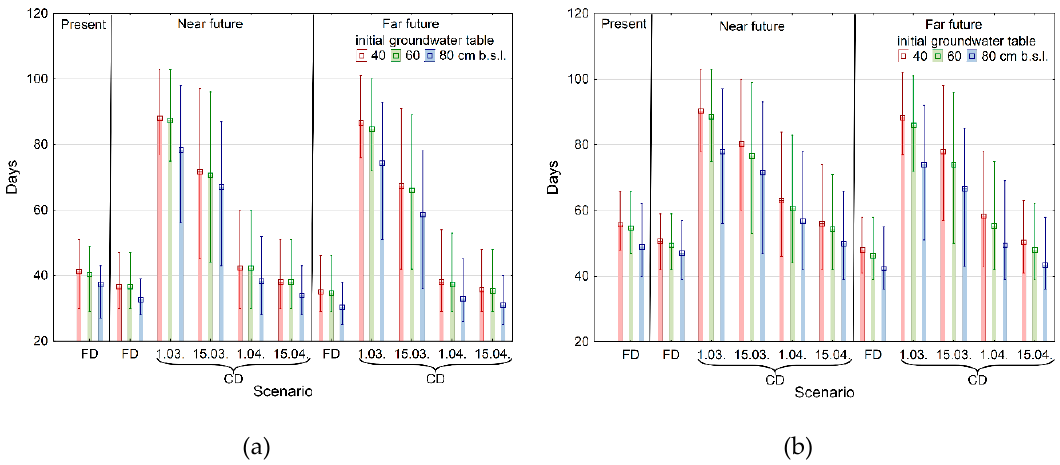
Figure 4. Impact of climate change on the time of groundwater location above the level of the drainage network with spacing of 7 m ( a ) and 14 m ( b ) (bar charts with error bars show the average values, as well as the minimum and maximum values for the years 2014, 2017, and 2018).